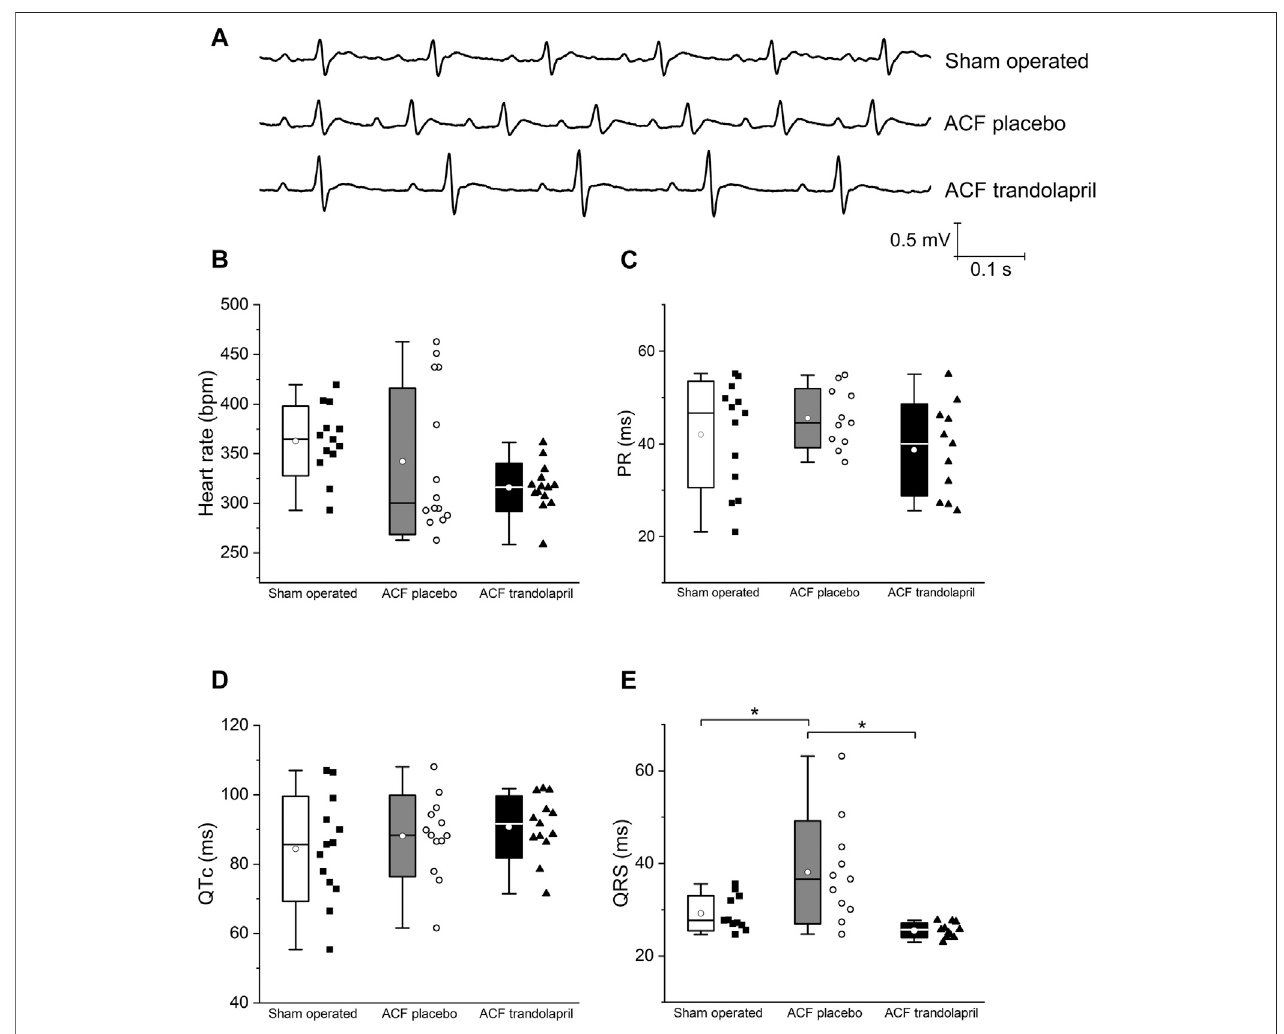
FIGURE2| Electrocardiographic intervals. (A) RepresentativeECG tracingsinasham-operatedrat, anACFrat, and anACF ratwithtrandolapril. (B) Heartratesin sham-operated rats ( n (cid:1) 13), ACF rats ( n (cid:1) 10) and ACF rats with trandolapril ( n (cid:1) 9). (C) PR intervals in sham-operated rats ( n (cid:1) 13), ACF rats ( n (cid:1) 10) and ACF rats with trandolapril ( n (cid:1) 9). (D) QTcintervals in sham-operated rats ( n (cid:1) 13), ACF rats ( n (cid:1) 10) and ACF rats with trandolapril ( n (cid:1) 9). (E) QRSintervals in sham-operated rats ( n (cid:1) 13), ACF rats ( n (cid:1) 10) and ACF rats with trandolapril ( n (cid:1) 9). * p < 0.05.